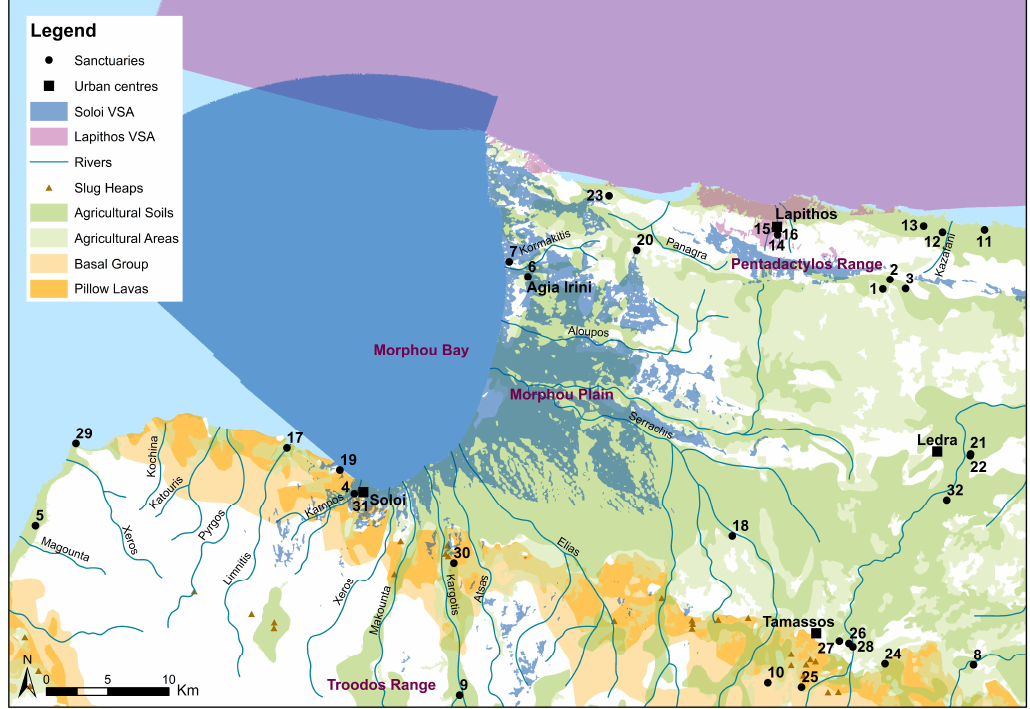
Figure 9. Visibility Analysis from Soloi and Lapithos; Digital data courtesy of the Geological Survey Department, Cyprus (by Charalambos